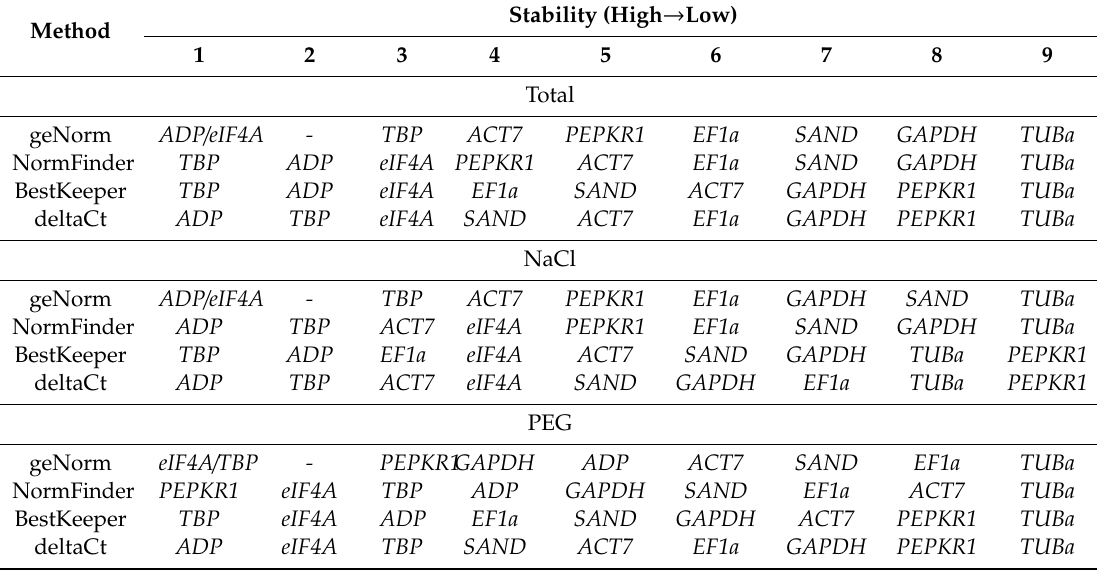
Table 3. Ranking of candidate reference genes stability according to all tested algorithms. Analyses were performed for NaCl treated samples (NaCl), PEG treated samples (PEG) and all samples combined together